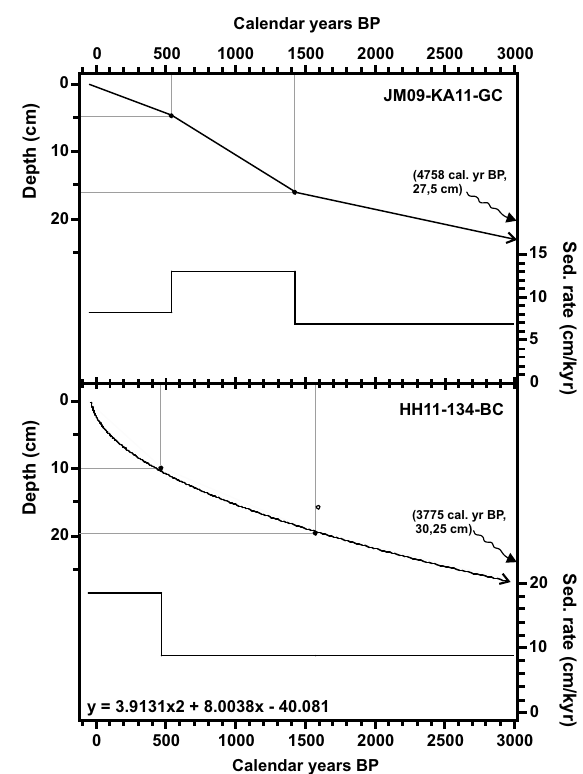
Fig. 2. Calendar age–depth model and sedimentation rates of JM09-KA11-GC (linear interpolation between each dated level) and HH11-134-BC (second order polynomia), based on data from Table 2. Filled circles: include AMS C 14 datings, hollow cir- cles: exclude AMS C 14 datings. The stratigraphic framework of core MD95-2011 was developed by Birks and Koc¸ (2002),